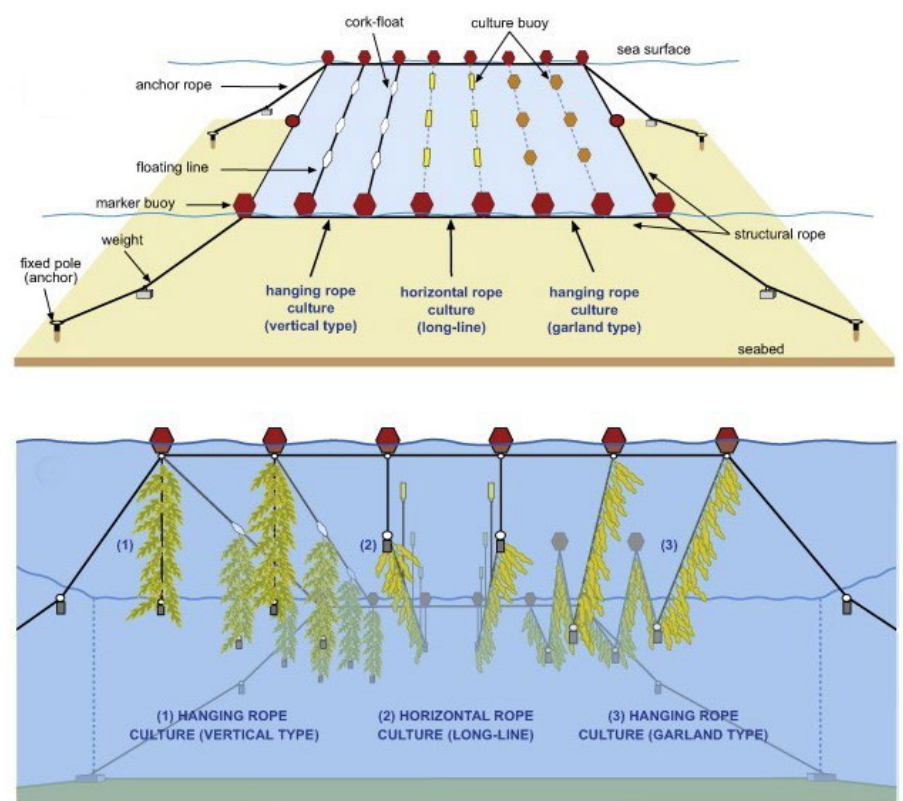
Figure 3. Variations on traditional culture rope systems. Reproduced with Permission [22].